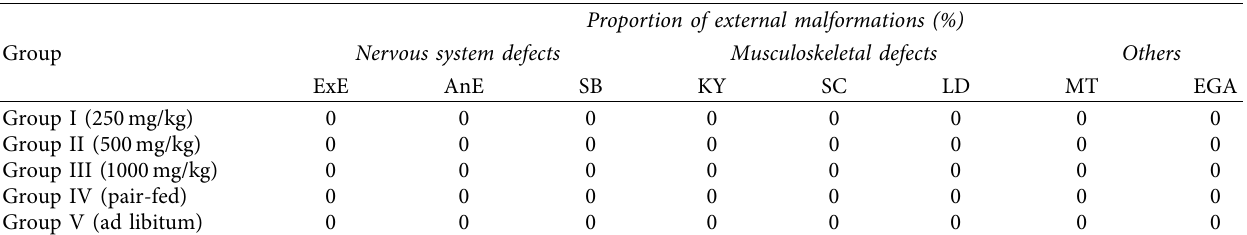
Table 9: External gross malformations after treatment with the 80% ethanol fruit extract of Embelia schimperi .